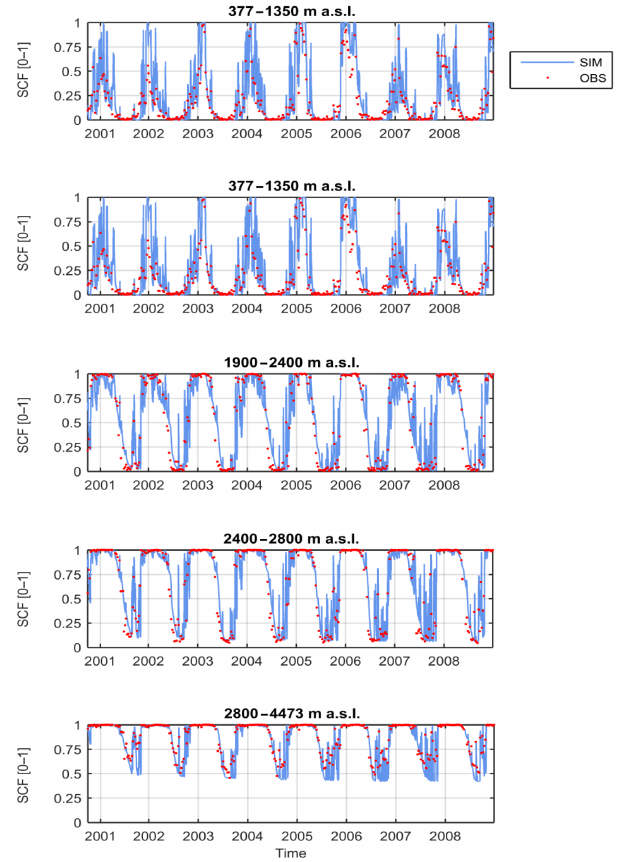
Figure 2. Comparison between observed (red circles) and simulated (light blue lines) snow-cover fraction (SCF) of the upper Rhône Basin for five different elevation bands. Simulations are computed with calibrated snowmelt factor k snow = 3 . 6mmday − 1 ◦ C − 1 .